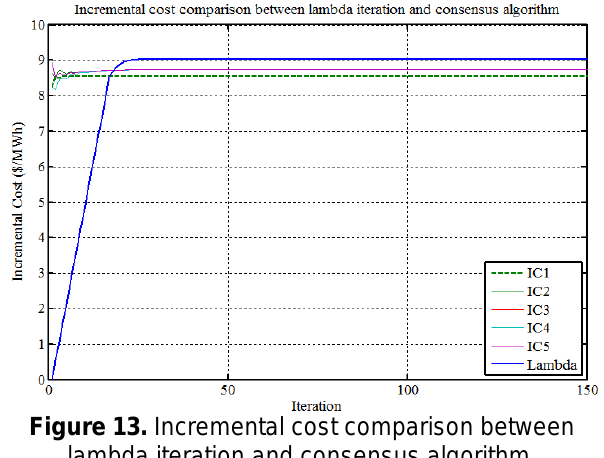
Figure 13. Incremental cost comparison between lambda iteration and consensus algorithm.